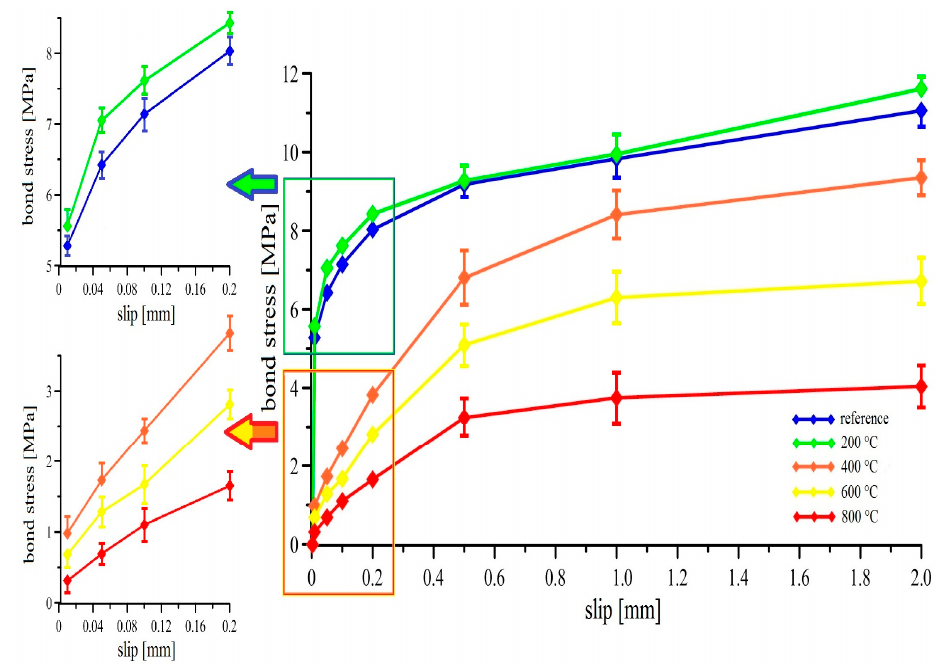
Figure 10. Bond strength curves of the prestressing reinforcement in the UHPC samples exposed to elevated temperatures.